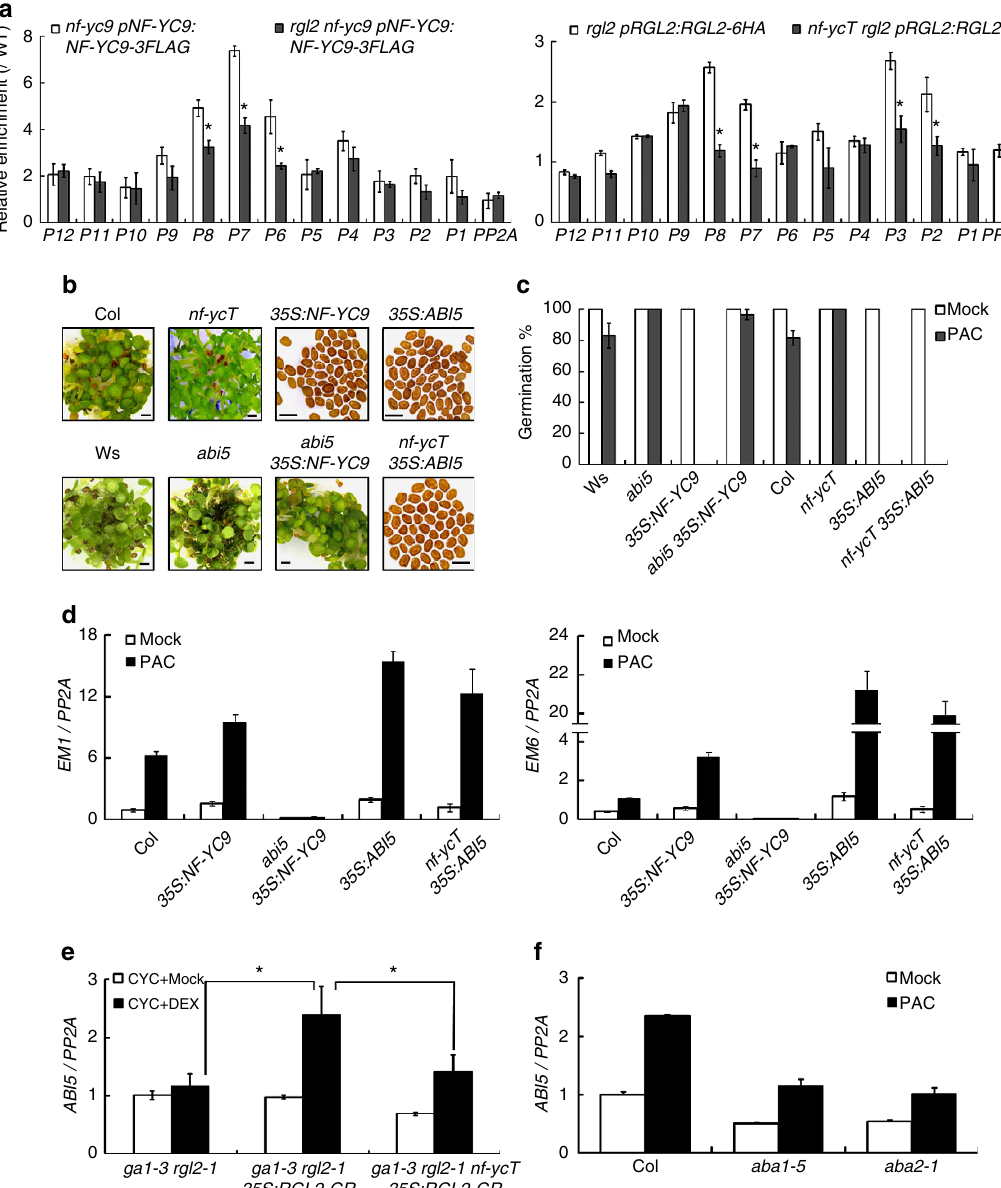
Figure 6 | ABI5 is required for NF-YC–RGL2-mediated seed germination. ( a ) ChIP analysis of NF-YC9 or RGL2 binding to CCAAT-box containing regions of ABI5 promoter upon precipitation with anti-FLAG or anti-HA antibodies in seeds under various genetic backgrounds. The seeds were grown on 1/2 MS medium containing 5 m M PAC for 12 HAS and harvested for ChIP assay. Data represent mean ± s.d. of triplicates. Asterisks indicate significant changes in ChIP-enrichment fold between crossed lines and relevant parent lines (Student’s t -test, P o 0.05). ( b ) Germination phenotypes of seeds in various genetic backgrounds observed at 120 HAS on 1/2 MS medium containing 1 m M PAC. ( c ) Statistic analysis of germination rate in the seeds described in b . Germination rate in all the seeds with mock treatment is 100%. Data represent mean ± s.d. of at least 100 seeds. Scale bar, 1mm. ( d ) Quantitative RT–PCR analysis of EM1 and EM6 expression in seeds in various genetic backgrounds grown on 1/2 MS medium containing 5 m M PAC or not for 12 HAS. ( e ) Quantitative RT–PCR analysis of ABI5 expression in ga1-3 rgl2-1 , ga1-3 rgl2-1 35S:RGL2-GR and ga1-3 rgl2-1 nf-ycT 35S:RGL2-GR seeds grown on 1/2 MS medium containing 10 m M cyclohexanone (CYC) or 10 m M CYC plus 10 m M dexamethasone (DEX) for 4h. Data represent mean ± s.d. of three replicates. Asterisks indicate significant changes between the selected samples (Student’s t -test, P o 0.05). ( f ) Quantitative RT–PCR analysis of ABI5 expression